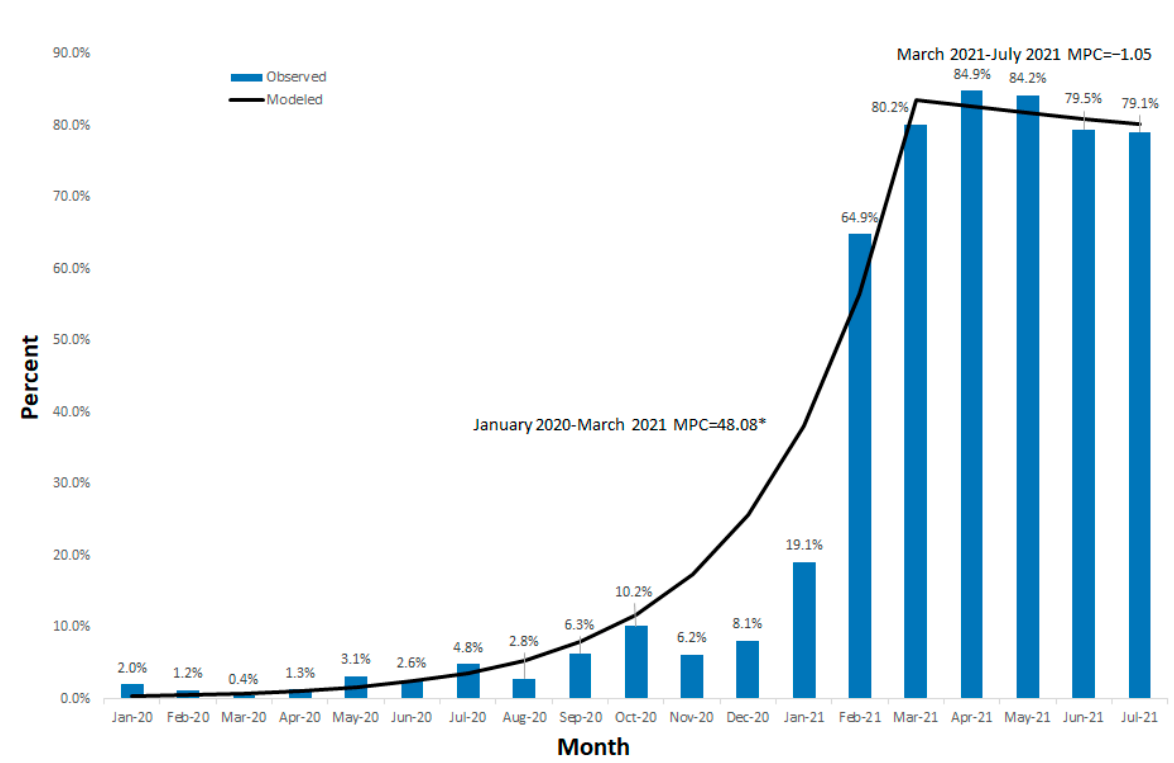
Figure 1. Seropositivity to SARS-CoV-2 between January 2020 and July 2021 in Israel, by month (N = 9520). * p -value < 0.05.